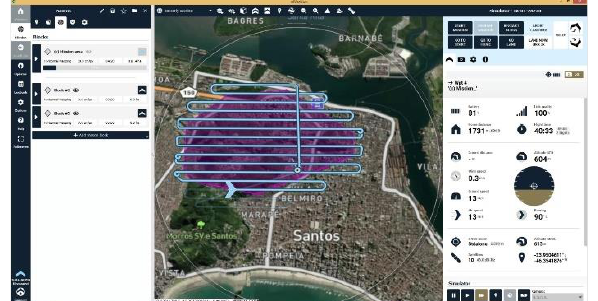
Figure 2. Flight plan simulation run by eMotion: eBee X operating software.